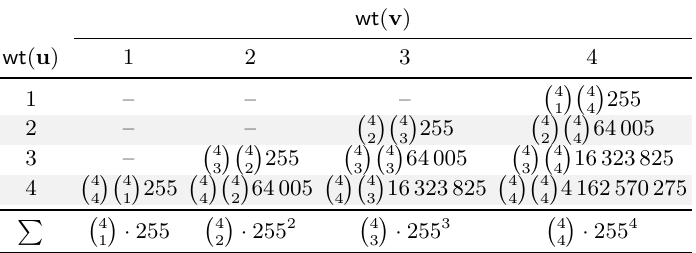
Table 7: Number of differences that translate from a diagonal vector x with active-byte pattern u to a column vector y with active-byte pattern v through one round of the AES , depending on the weight of u and v